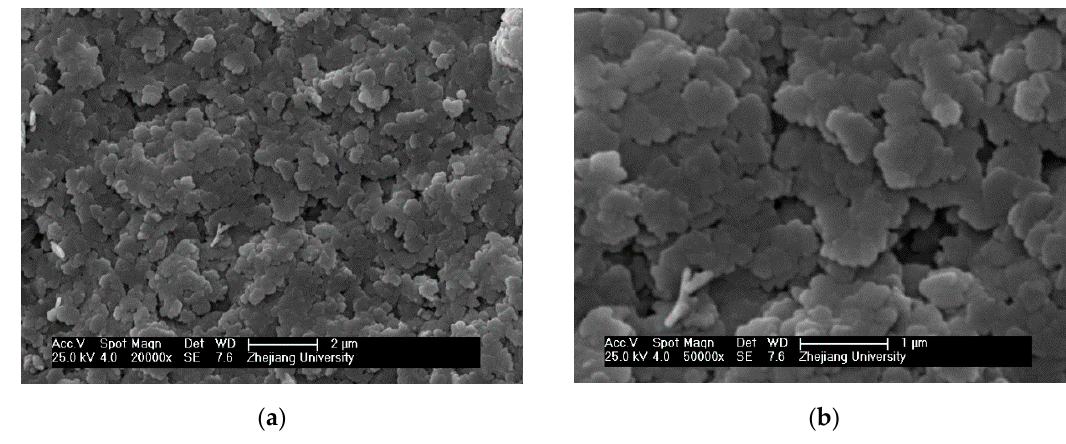
Figure 2. SEM morphology of the nano–Ni(OH) 2 sample at different scales. ( a ) ×20,000, ( b ) ×50,000.